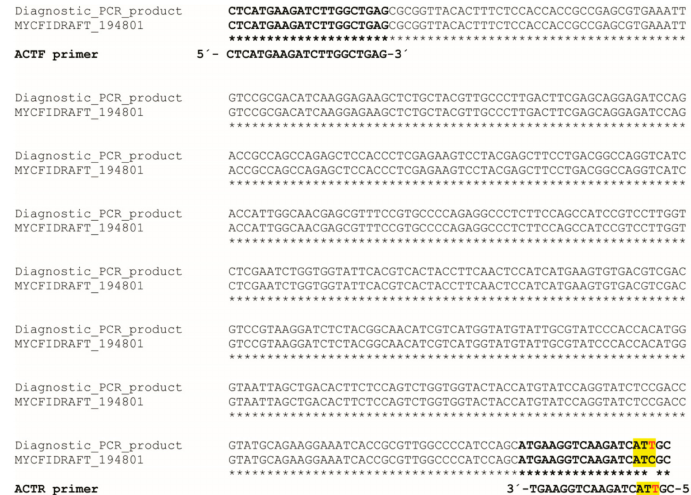
Figure 2. Nucleotide alignment of partial sequences of the actin gene of P. fijiensis . Diagnostic PCR product is a representative sequence of PCR products amplified on DNA templates from leaf spot on Heliconia psittacorum , Wedelia trilobata , Xantosoma robustum and Digitaria sp. plants collected inside and around commercial banana plantations. MYCFIDRAFT_194801 corresponds to the genomic sequence of XM_007925807.1 (mRNA), the first hit in the GenBank retrieved with the query. One Single Nucleotide is observed (in bold red), which is present in the reverse primer. Highlighted in yellow: the di ff erent codons between our sequences and the reference sequence. Both codons, ATT and ATC, codify for isoleucine.